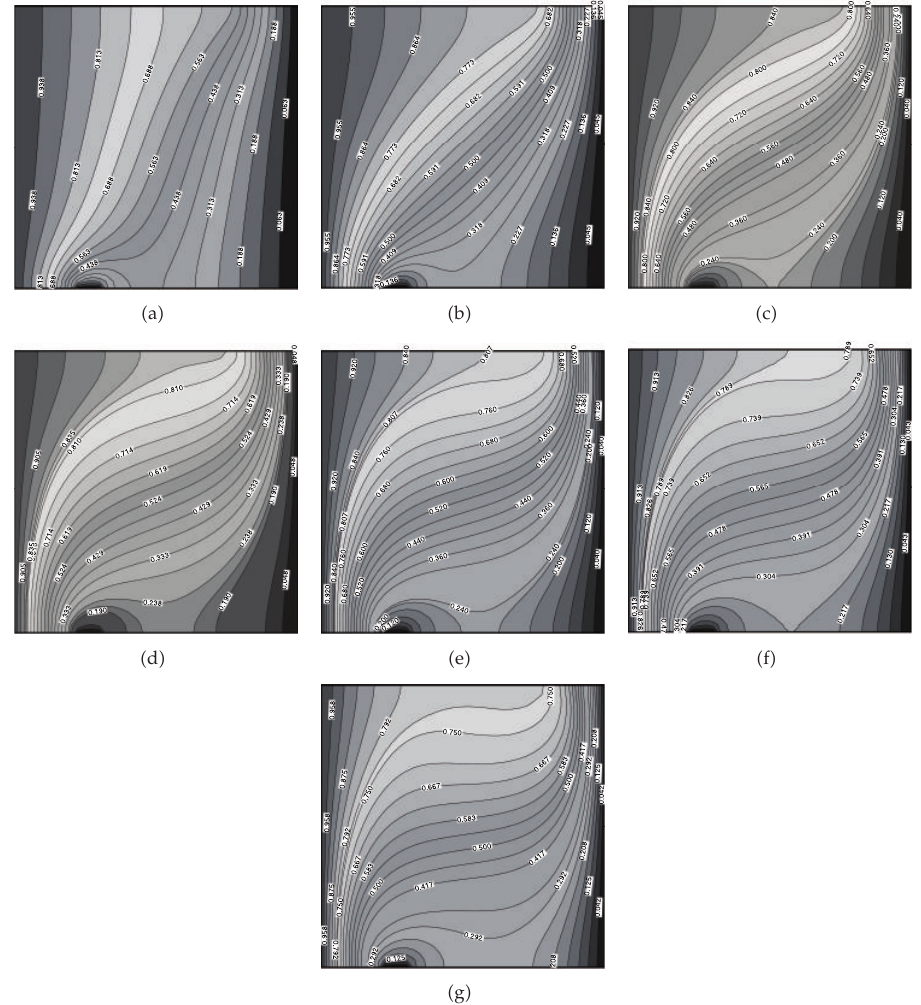
Figure 13: Isotherm contours along the left vertical wall while fixing Le (cid:8) 1, D/H (cid:8) 0 . 1, (cid:2) a (cid:3) (cid:8) 0.1, Ra (cid:8) 100, S C (cid:8) 0 . 1 for (cid:2) a (cid:3) B (cid:8) − 1 . 5, (cid:2) b (cid:3) B (cid:8) − 1, (cid:2) c (cid:3) B (cid:8) − 0 . 5, (cid:2) d (cid:3) B (cid:8) 0, (cid:2) e (cid:3) B (cid:8) 0 . 5, (cid:2) f (cid:3) B (cid:8) 1, (cid:2) g (cid:3) B (cid:8) 1 .